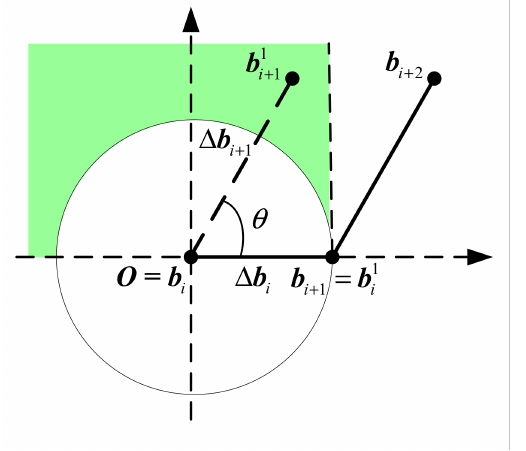
Figure 2. The domain of b 1 for s · cos θ < 1 ( s ≥ 1, θ ∈ [ 0, π ] ) in the local coordinate i + 1